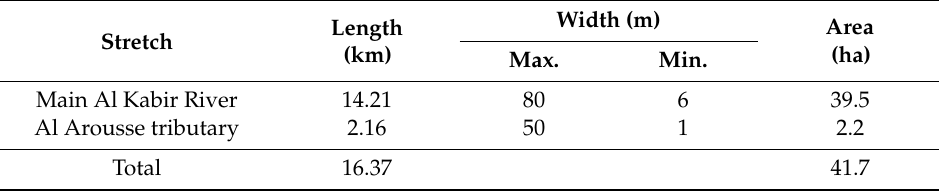
Table 2. The hydrographic network surface of the studied